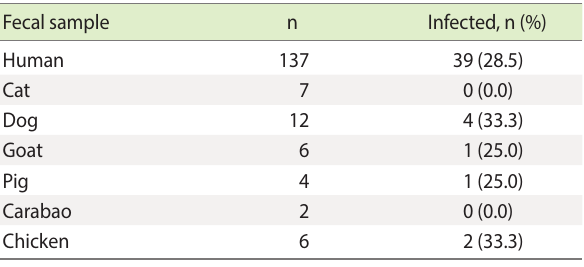
Table 1. Prevalence of Cryptosporidium infection in human and ani- mal samples